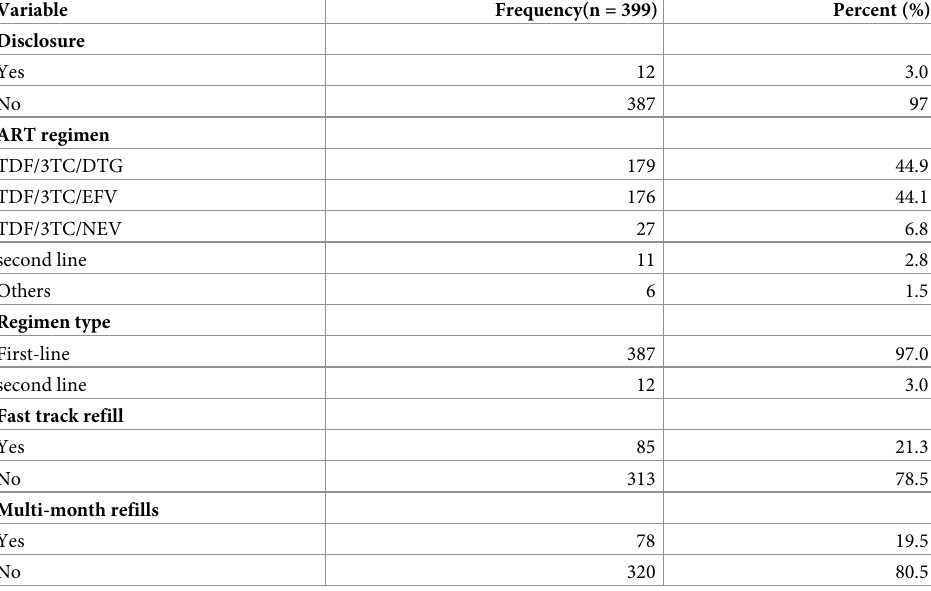
Table 2. Participant’s medical characteristics.